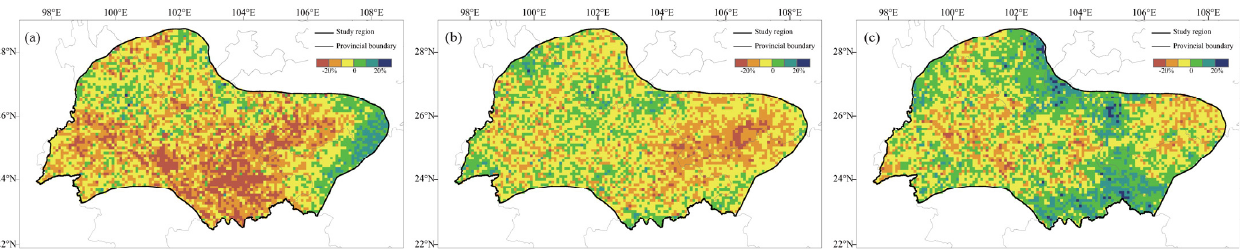
Figure 4. The spatial distributions of NDVI anomaly percentage in the spring (March–May) of 2010 ( a ), 1999 ( b ), and 2013 ( c ) relative to the average for the period 2000–2009. Similar to the results of NDVI, the concurrent events also significantly reduced spring vegetation productivity within the study region. Relative to the average NPP in spring for the period 2000–2009 in the study region, the NPP in the spring of 2010 decreased by an average of approximately 23% and the total NPP decreased by 10.51 Tg C a − 1 . The NPP in the spring of 1999 decreased by an average of 10.49%, and the total NPP decreased by 3.48 Tg C a − 1 . The NPP in the spring of 2013 was an overall positive anomaly with an increase of approximately 3%. The spatial distribution of anomaly percentage of NPP is basically similar to that of NDVI, except for differences in intensity (Figure 5).